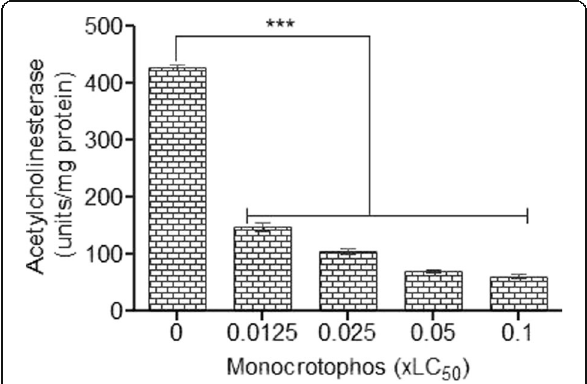
Fig. 2 Acetylcholinesterase inhibition in Caenorhabditis elegans by monocrotophos after 4 h of exposure. Values are mean±SE ( n =9). *** p <0.001